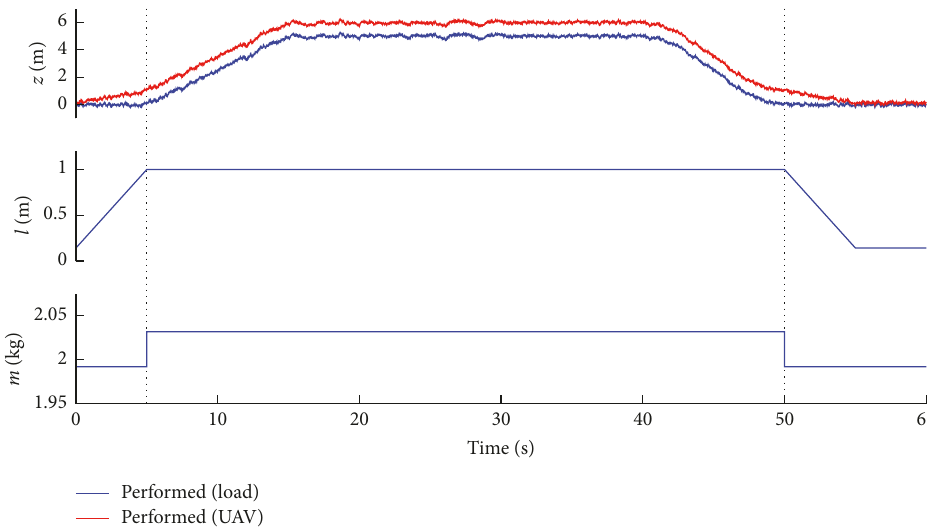
Figure 9: Analysis of the time evolution of the load and UAV altitude in take-off and landing maneuvers together with the rope’s length and the total mass variation.